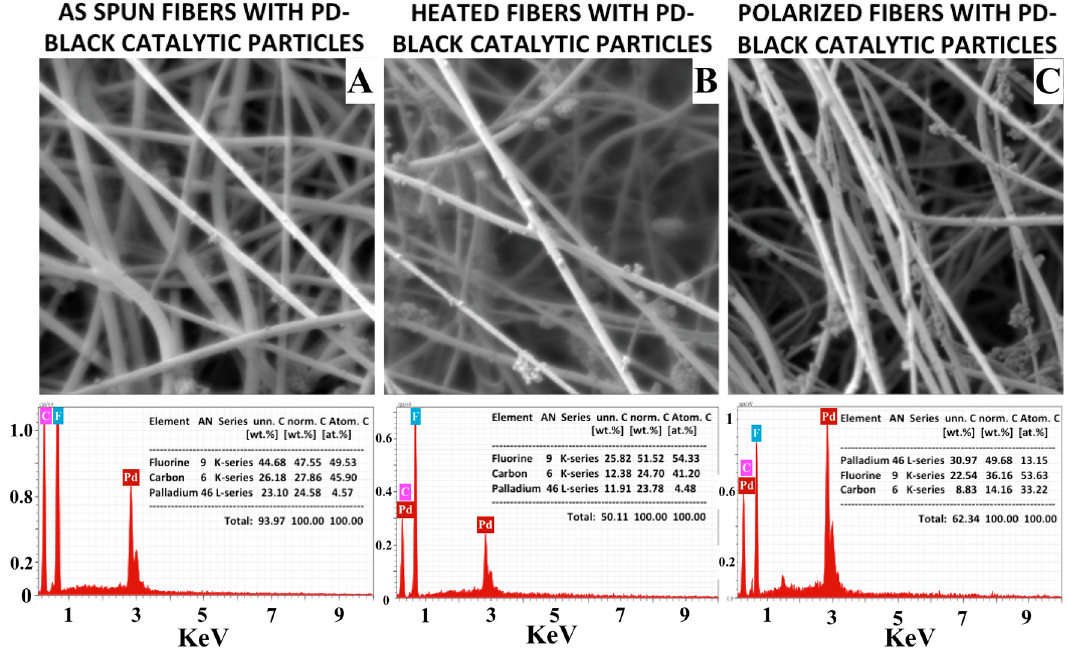
Figure 7. SEM micrographs of catalytic particles embedded on to ( A ) as-spun, ( B ) heat-treated, and ( C ) polarized PVDF fibers and corresponding EDX spectra analysis of elemental composition on the bottom.